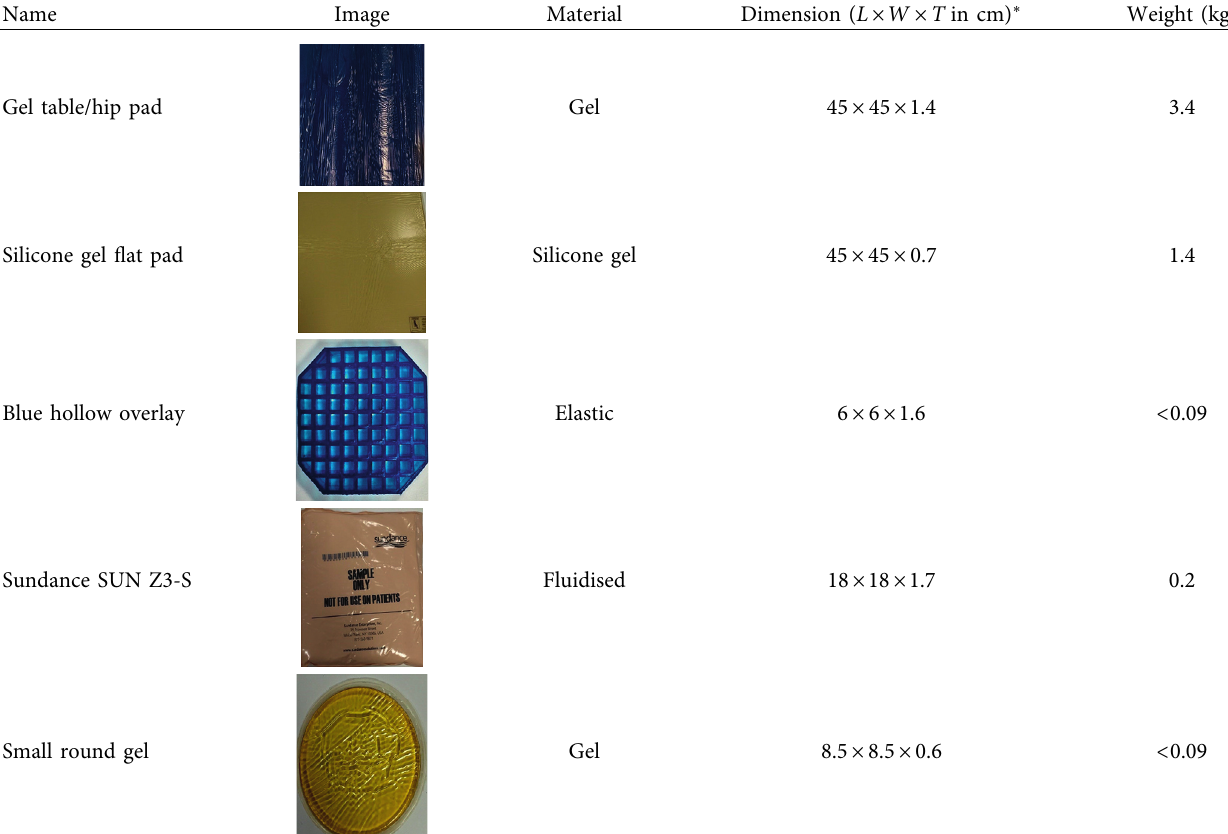
Table 1: Physical characteristics of the five static surface overlays.